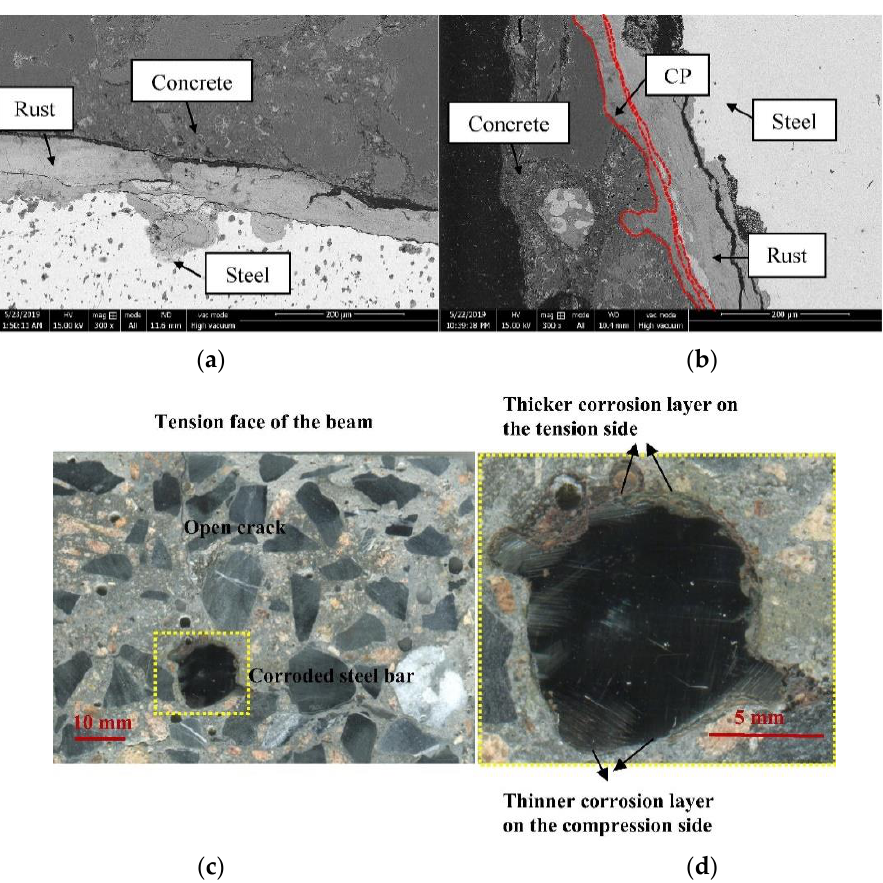
Figure 6. Images showing CP in NAC ( a ) and RAC ( b ) (reproduced from [97]) and in RAC under load ( c , d ). Reproduced with permission from Ref. [98]. 2019, Elsevier.